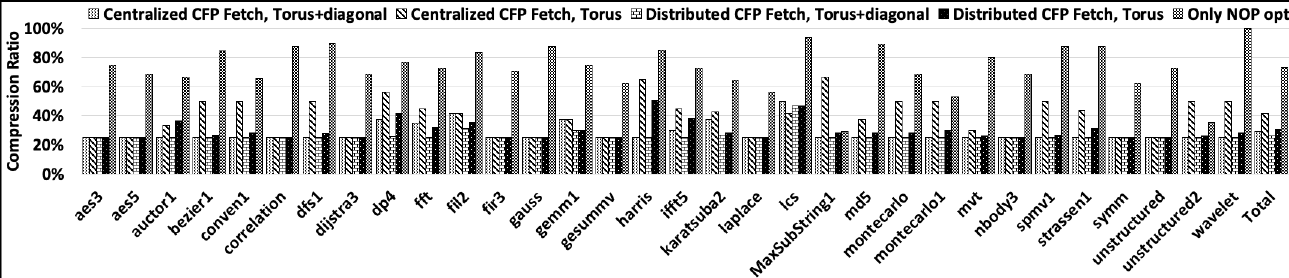
Figure 13. The context compression ratio of the centralized and decentralized CFP-fetching CGRA, and the baseline CGRA using NOP-removal technique